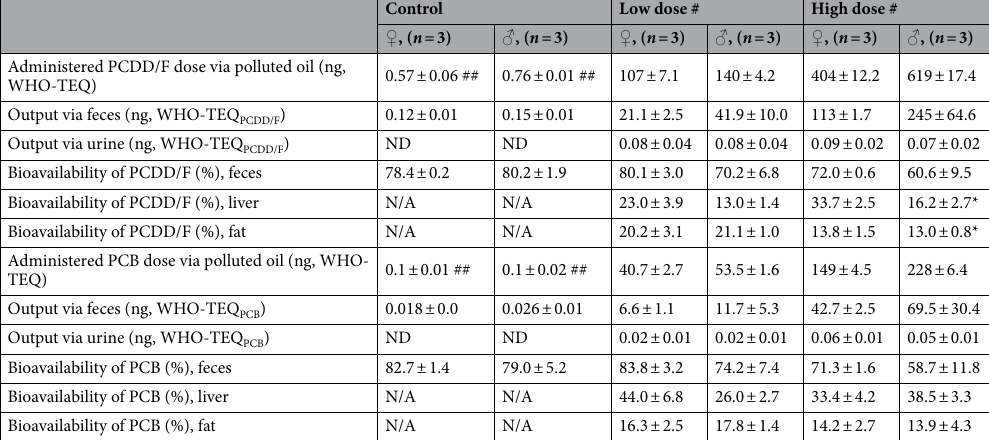
Table 2. The TEQ bioavailability of PCDD/F & PCB calculated by different endpoints. #For PCDD/F: Low dose: 0.2 ng/100 g b.w./d; High dose: 1 ng/100 g b.w./d; For PCB: Low dose: 1 ng/100 g b.w./d; High dose: 5 ng/100 g b.w./d. ##For control group, SD rats were administrated with blank oil containing negligible PCDD/F or PCB. Values showed in the table were background level pre-existed in feeds. ND Not detected; N / A Not applicable. *significant difference comparison between female and male, t -test, type1, tail 2, p < 0.05.